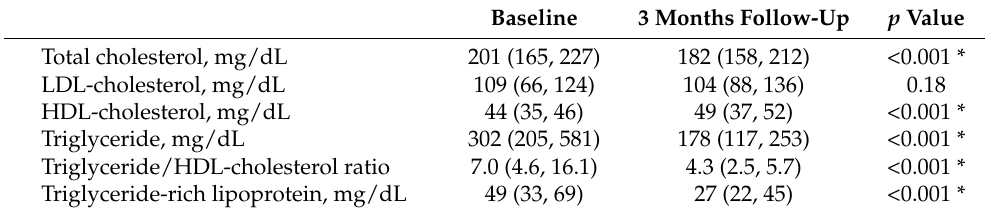
Table 2. The trends in lipid parameters during 3-month pemafibrate therapy.